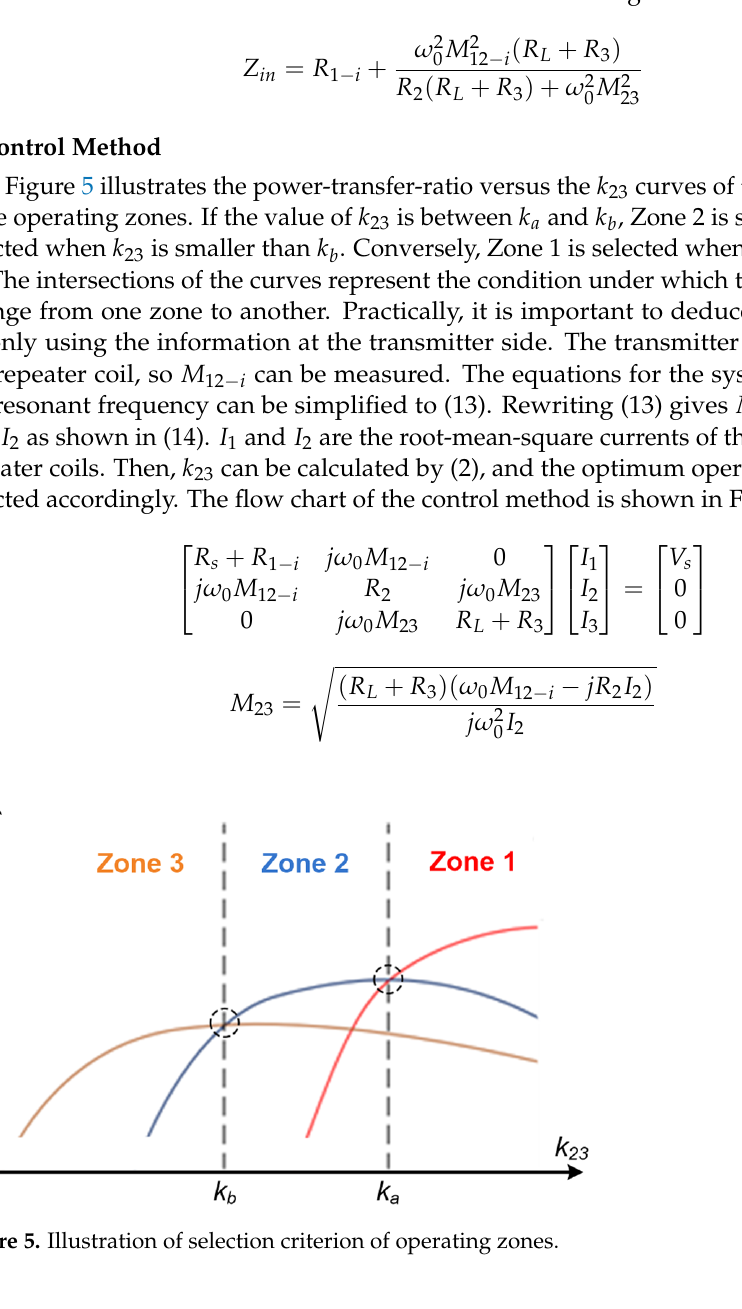
Figure 6. Flow chart of the control method. 5. Experimental Verification 5.1. Desgin Methodology A proof-of-concept prototype was built to verify the performance of the proposed system (see Figure 7). A function generator (Tektronix AFG3102C) and a high-speed bi- polar amplifier (HAS 4101) were used to provide an AC voltage source generating a si- nusoidal wave with constant frequency and magnitude. The size of the repeater coil and the receiver coil were the same, each with a 10 cm radius in a helical structure. Litz wires were used to reduce the AC resistance in the coils. The number of turns of the coils was nine. The Q-factor of the coils reached 527 when the operating frequency was 585 kHz. All the parameters of the repeater coil and the receiver coil are shown in Table 1. The relation- ship between 𝑘 (cid:2870)(cid:2871) and transmission distance is shown in Figure 8a. The 𝑘 (cid:2870)(cid:2871) varied from 0.12 to 0.038 in the range of 10~20 cm. The value of 𝑘 (cid:2870)(cid:2871) versus the lateral misalignment from the center of the coil was also measured at the transmission distance of 10 cm. It varied from 0.12 to 0.036 with the misalignment from 0~14 cm, as shown in Figure 8b. A 3D plot of k 23 versus both dimension changes is shown in Figure 9.